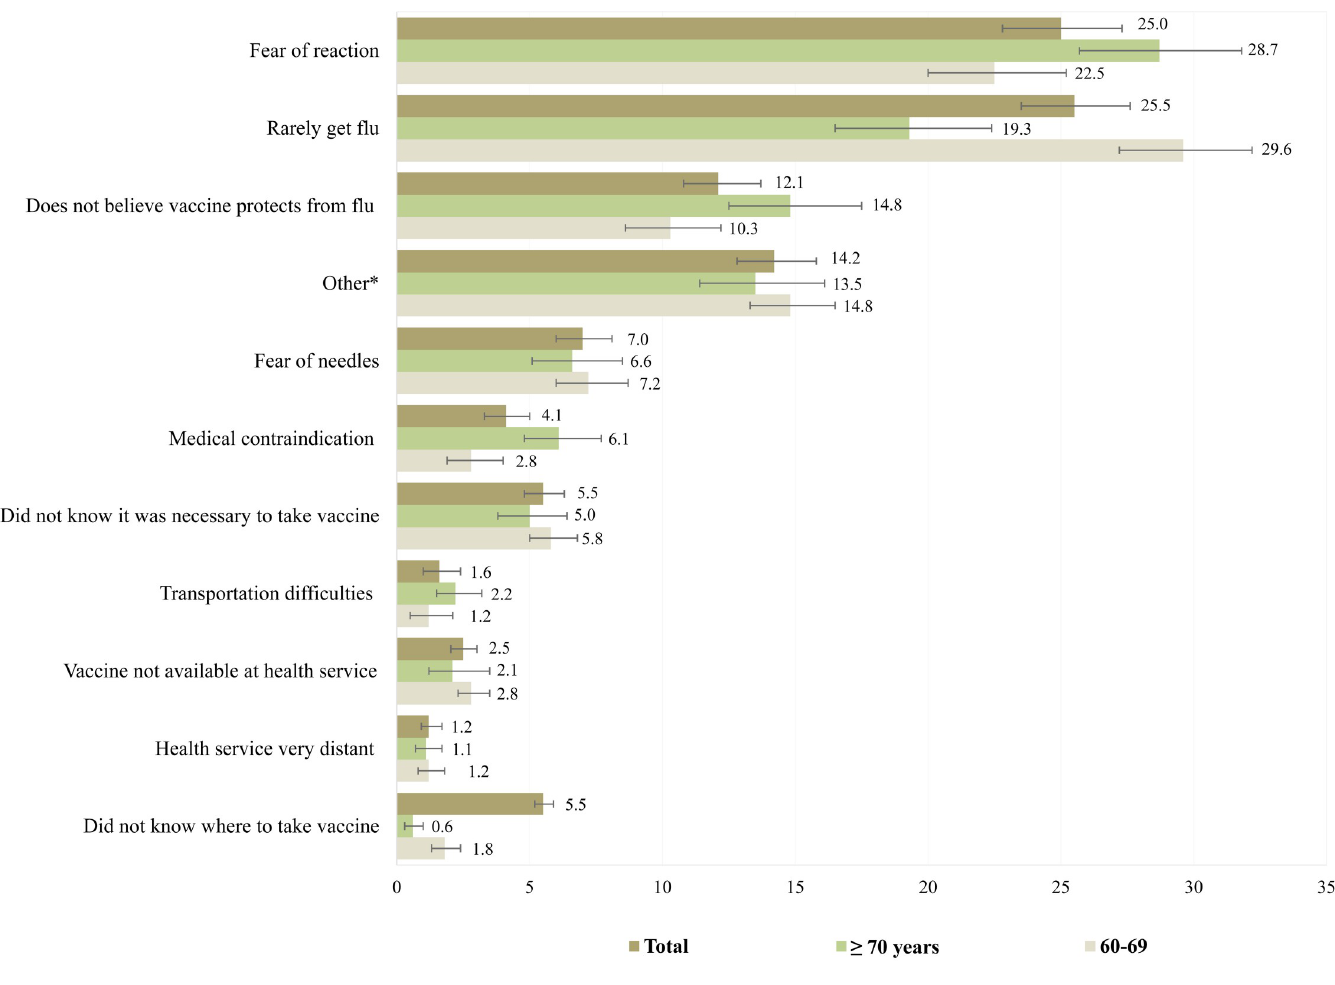
Fig 1. Percentage distribution of main reasons for nonadherence of older people to vaccination for influenza according to age group. National Health Survey, Brazil, 2013.